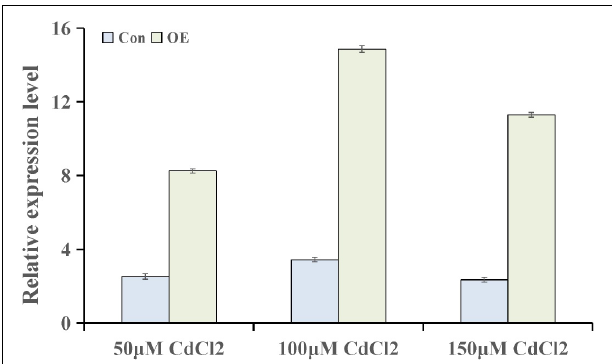
FIGURE 6 | The expression levels of ThUGT gene in transiently transformed T. hispida under different CdCl 2 stress conditions.